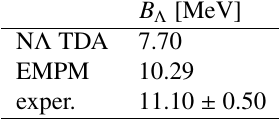
Table 1. Ground-state Λ separation energies B Λ obtained by the N Λ TDA and EMPM in comparison with the experimental value